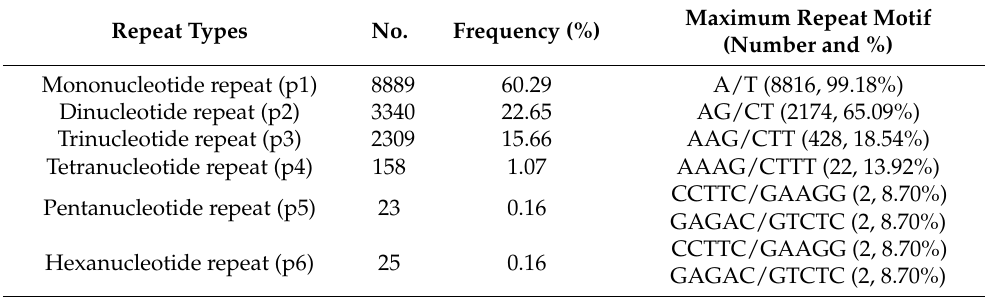
Maximum Repeat Motif (Number and %)